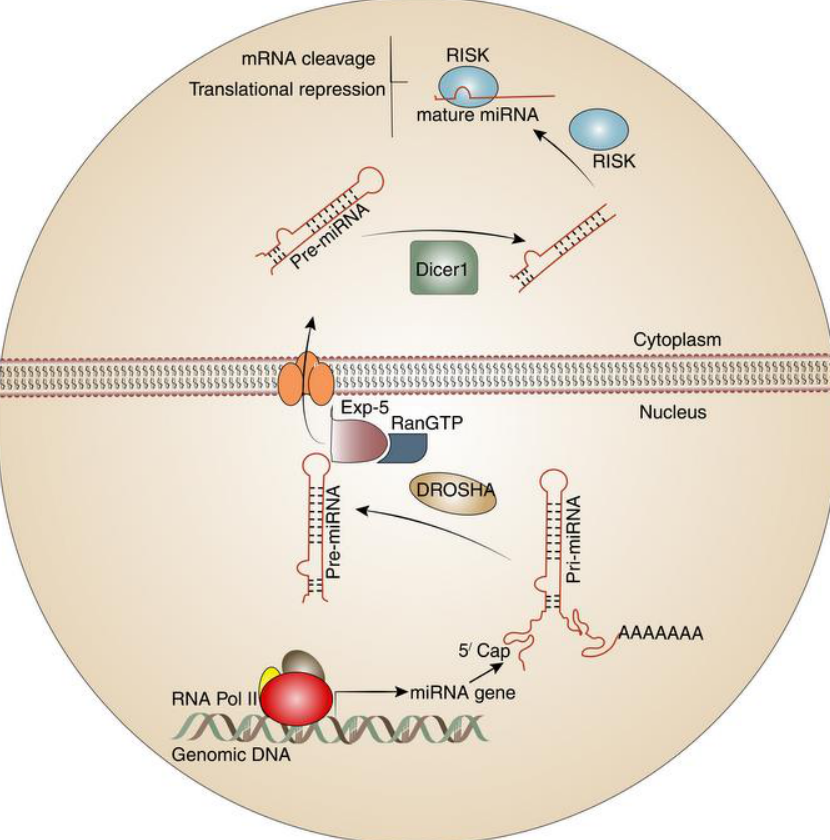
Figure 1. MiRNA biogenesis. Following transcription of miRNA by RNA polymerase in the nucleus, pre-miRNA was generated with a stem-loop structure. Immature miRNAs would be further processed by Drosha and Dicer in the nucleus and cytoplasm, respectively, leading to mature miRNA synthesis. The mature miRNA could incorporate into the RISC. The RISC complex binds to the target mRNA, leading to mRNA cleavage or translational regulation. Abbreviations: Exp-5: Exportin-5; RanGTP: GTP-bound